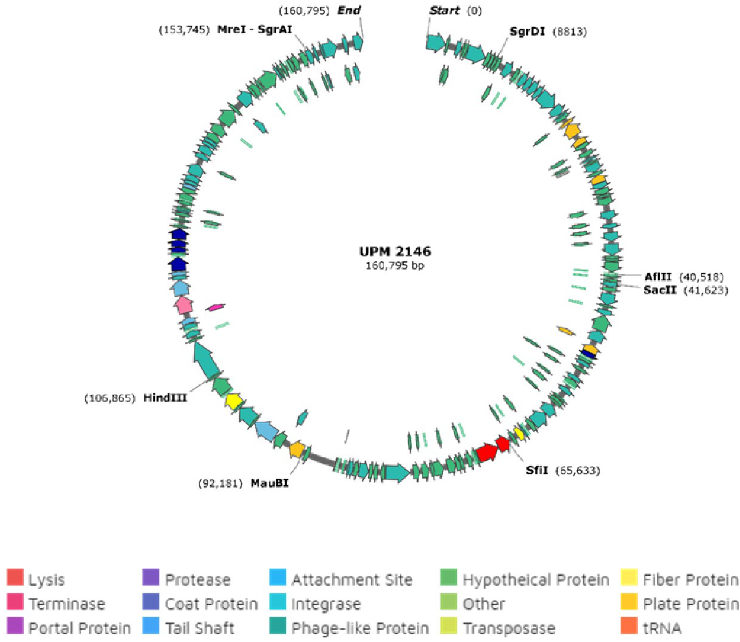
Fig 6. Whole genomic sequence of UPM2146 showing the absence of lysogenic genes such as integrase and toxin genes. This indicates the potential of UPM2416 in phage therapy. The circular genome map was constructed using